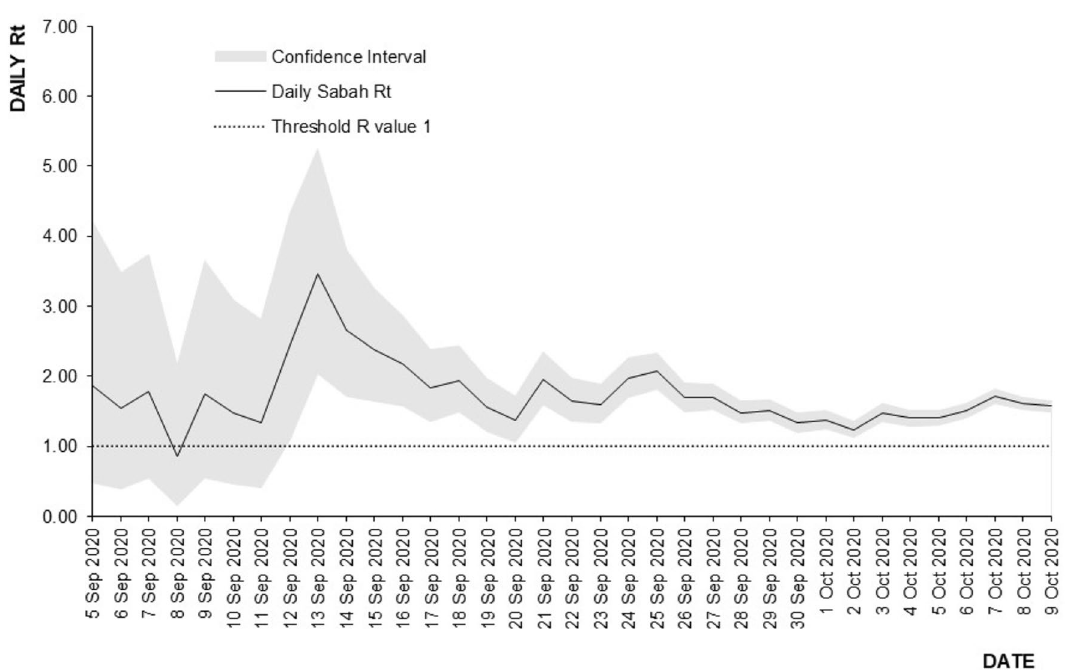
Figure 9. Rt trend following Sabah electoral event, 5 September 2020 to 9 October 2020,